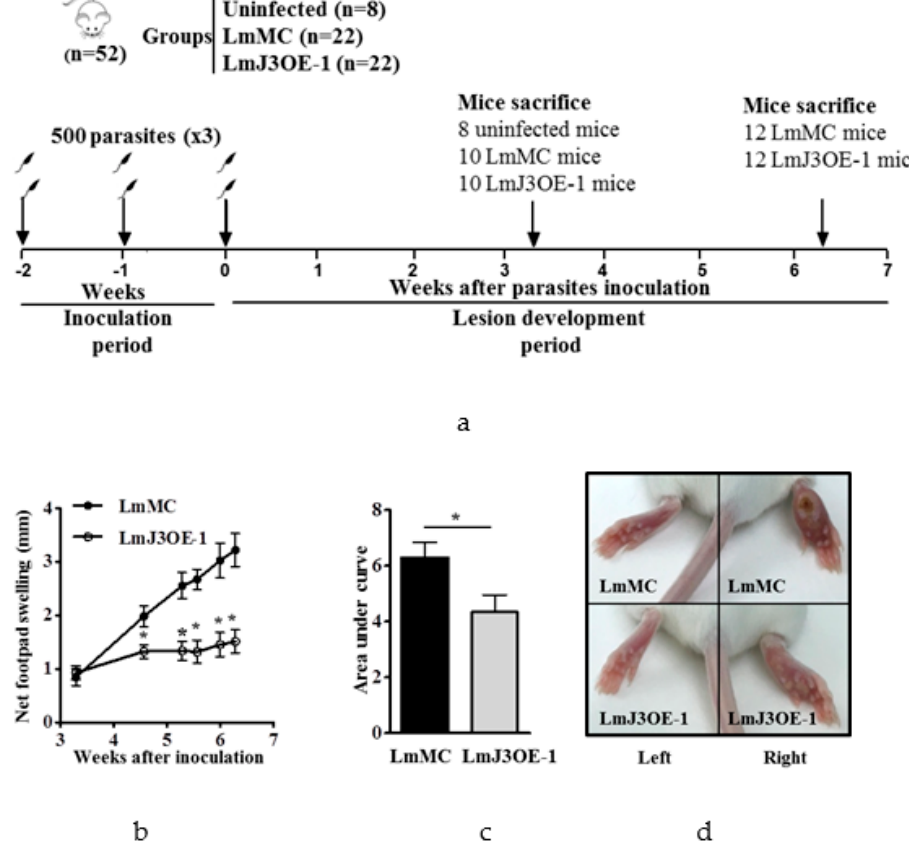
Figure 3. Virulence shown by LmjF.22.0810-overexpressing parasites in BALB / c mice. ( a ) Schematic representation of the experimental setting. During the inoculation period, animals were subcutaneously infected in the right footpad with 500 metacyclic parasites, overexpressing (LmJ3OE-1) or not overexpressing (LmMC) LmjF.22.0810. Three cycles of inoculation were carried out once a week. After the last inoculation, the swelling was measured weekly until the end of the experiment (lesion development period). The “ black arrows ” indicate the three cycles of inoculation (1 per week) and the two time points when mice were euthanized (days 23 and 44 after the last inoculation). ( b ) Net footpad swelling corresponds to the di ff erence between the infected and non-infected footpad, measured weekly until 44 days after last parasite inoculation (both LmMC and LmJ3OE-1 strains). ( c ) Area under the curve for net footpad swelling from mice inoculated with LmMC or LmJ3OE-1 parasites. ( d ) Representative images of inoculated (right) and non-inoculated (left) footpads of mice infected with parasites overexpressing (LmJ3OE-1) or not overexpressing (LmMC) LmjF.22.0810. Bars represent the means ( ± SD) (* p <